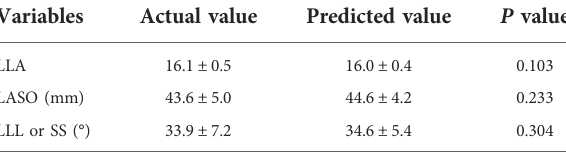
TABLE 7 Comparison between actual and predicted values of spinopelvic parameters in the validation